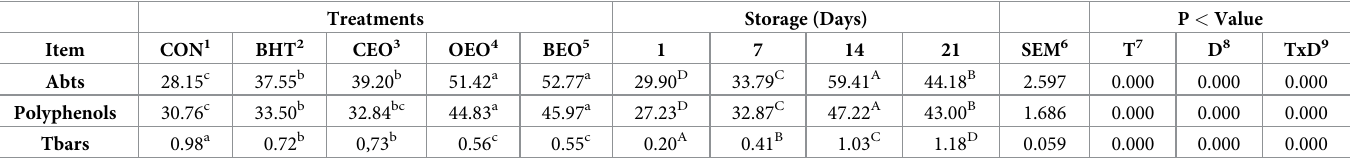
Table 2. Evolution of lipid oxidation (TBARs), antioxidant activity ABTS, and total phenolic compounds treated with BHT, copaiba and oregano essential oil or blend of essential oils during storage.